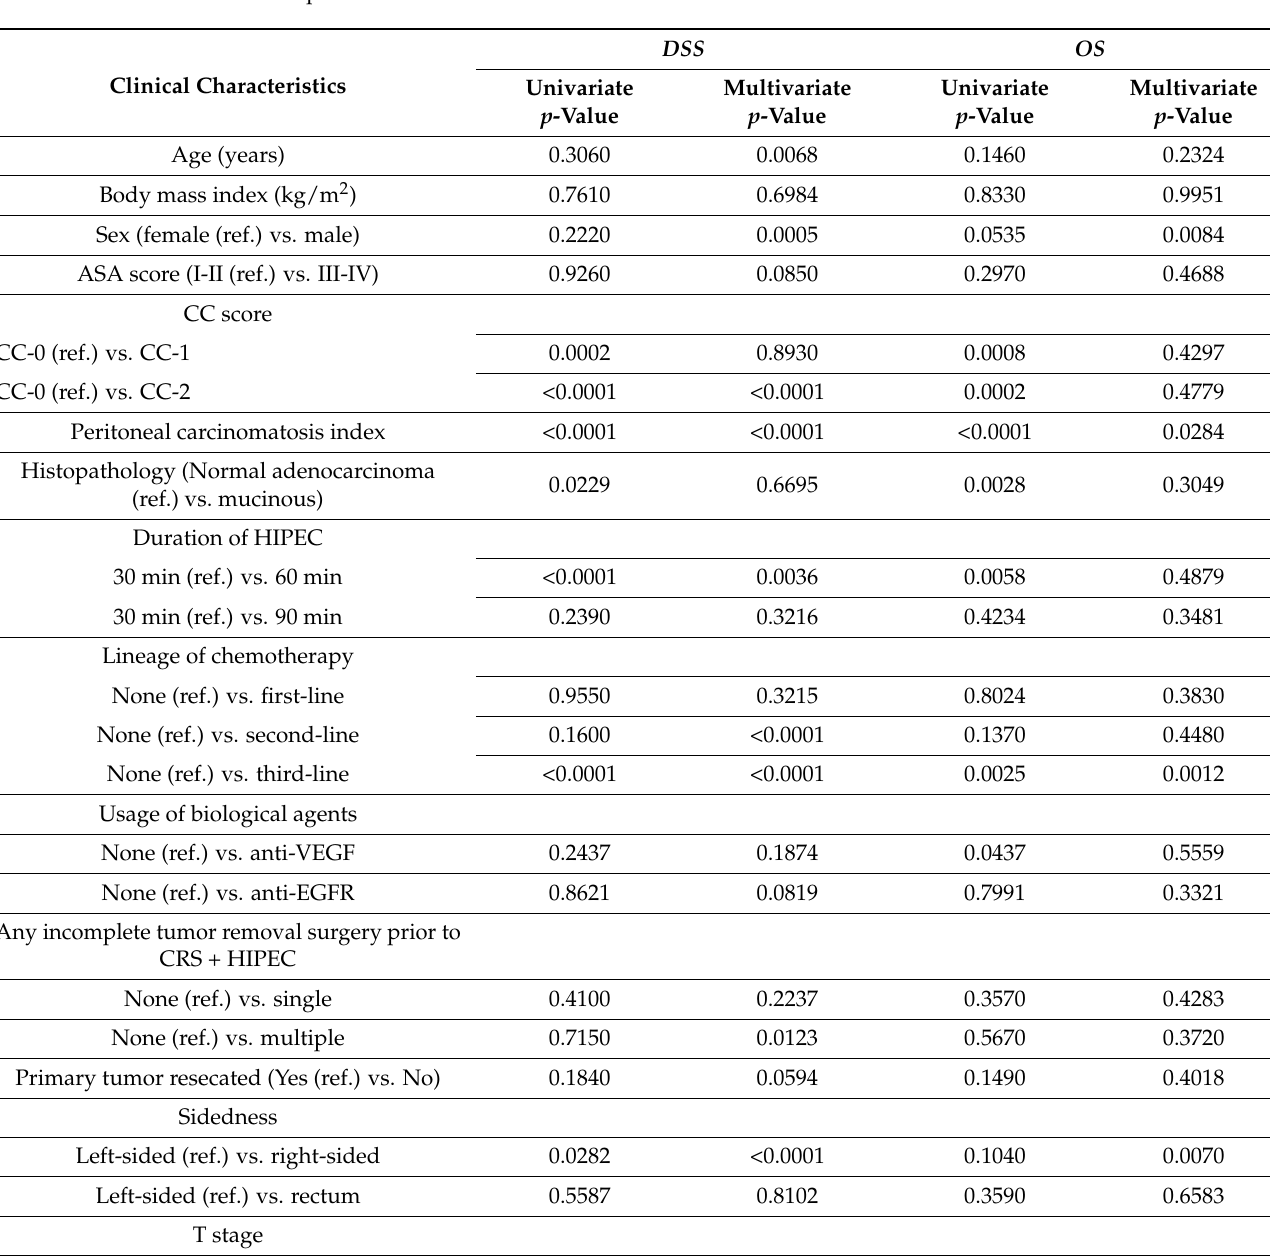
Table 2. Results of uni- and multivariate survival models of study participants with synchronous peritoneal